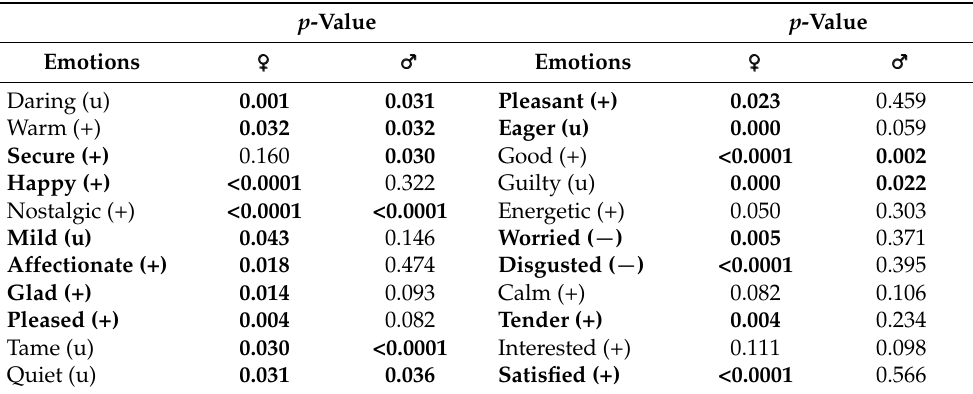
Table 3. Cochran’s Q test for significant differences between the 22 selected emotion terms of the CATA EsSense Profile ® by gender.